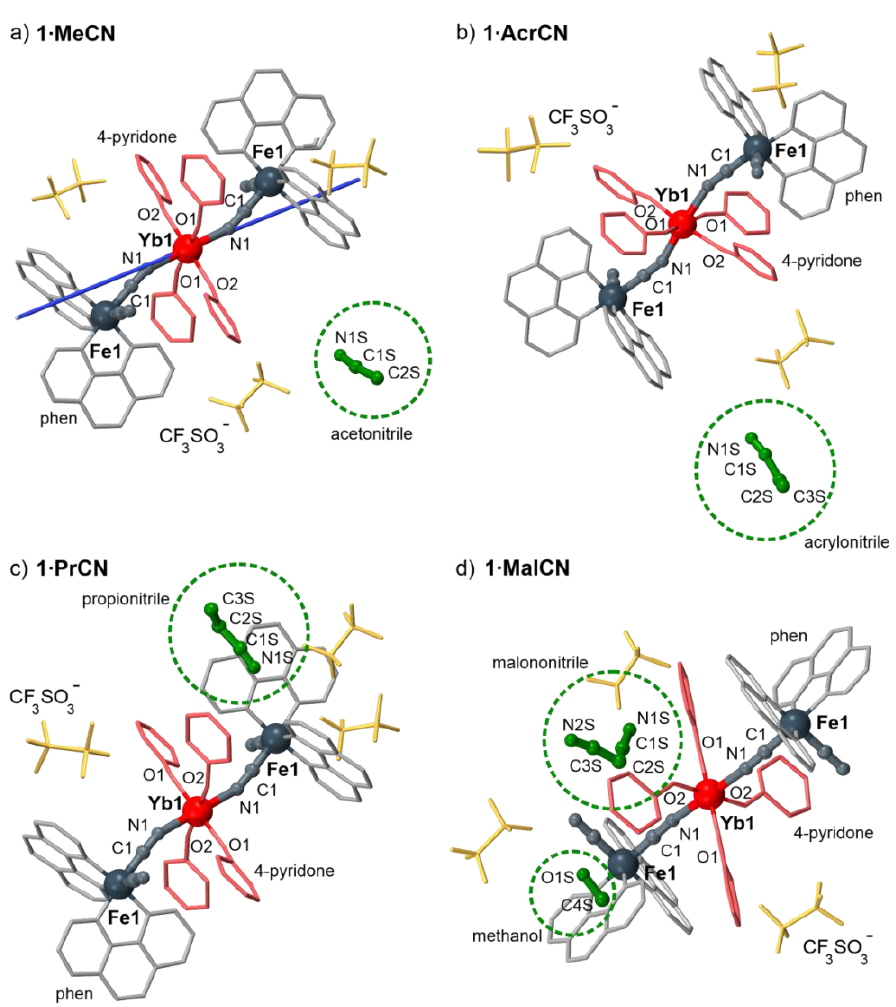
Figure 1. Representative molecular building units of 1∙MeCN ( a ), 1∙AcrCN ( b ), 1∙PrCN ( c ), and 1∙MalCN ( d ) with atoms labeling schemes and indicated components: organic ligands, counter-ions, and solvent of crystallization (marked by green circles). In ( a ), the blue line shows the easy magnetic axis (direction of the g z component of the pseudo- g -tensor of the ground state) determined by the ab initio calculations (Table S11 and details in Supporting Information).